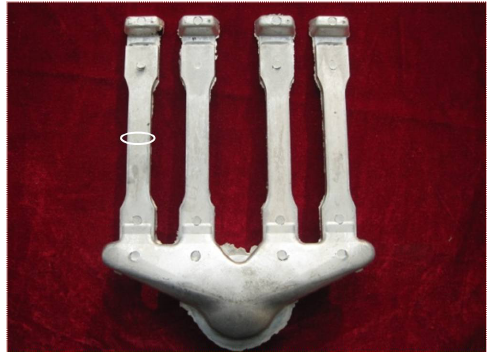
Figure 5. Schematic diagram of the rheo ‐ diecasting product.